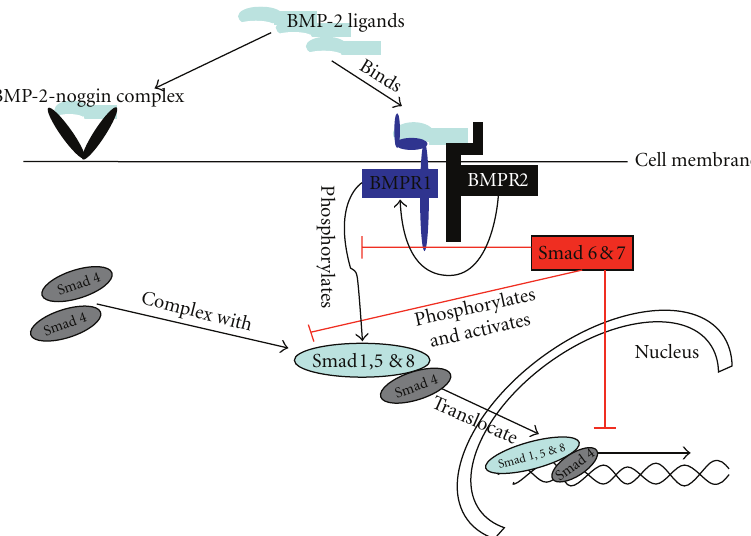
Figure 1: BMP binds to Type I (BMPR1A, BMPR1B) and Type II (BMPRII) serine threonine kinase transmembrane receptors and triggers a signal transduction cascade initiated via Smad family proteins. Signaling cascade through Smad take place via three Smad family proteins: receptor-mediated